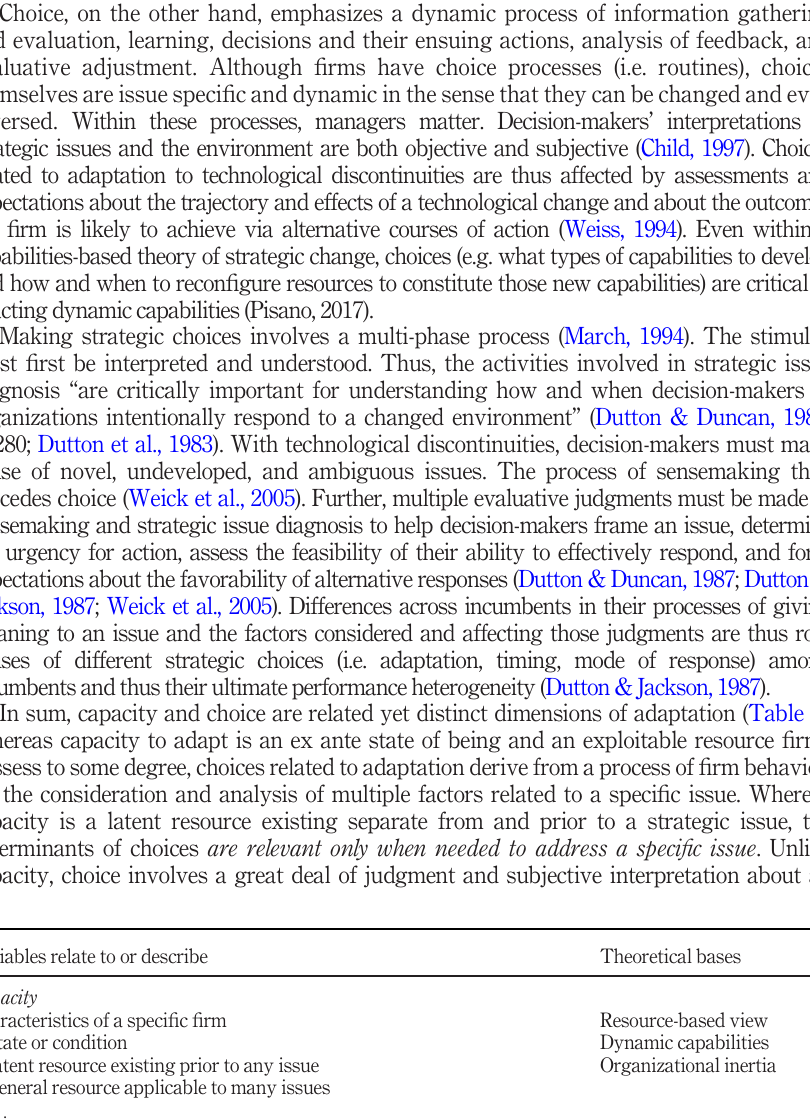
characteristics and underlying theory of capacity and